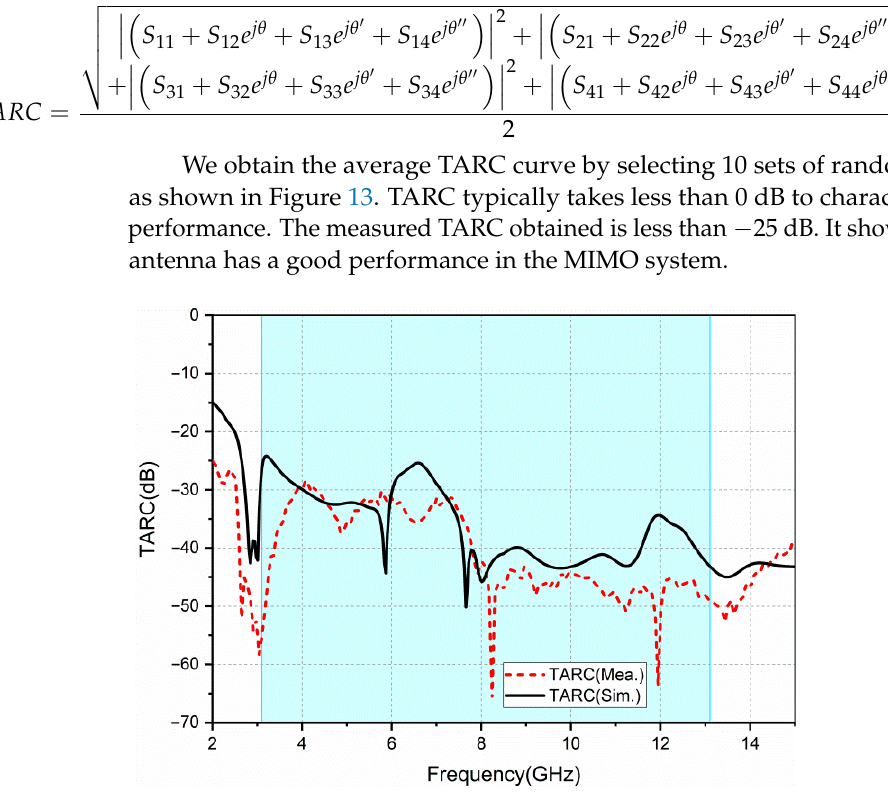
Figure 13. Simulated and measured TARC.